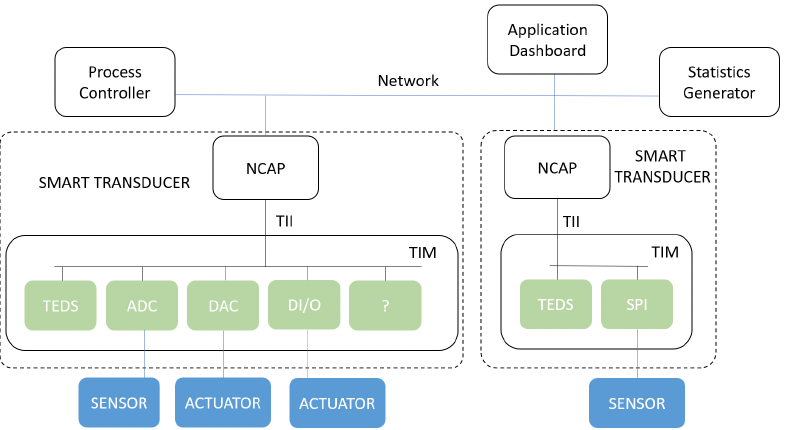
Figure 2. Basic architecture for a distributed control loop based on smart